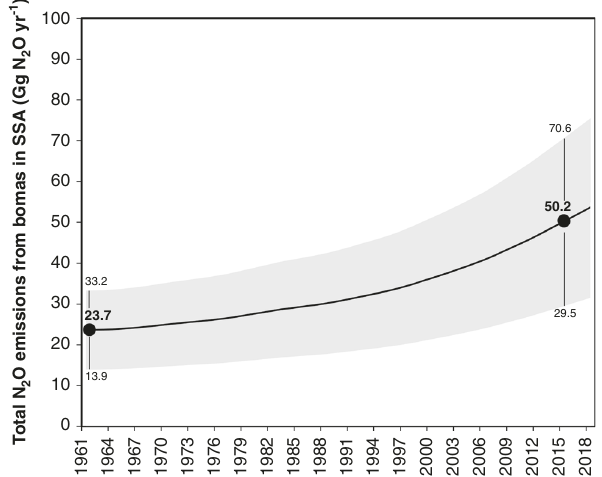
19611964196719701973197619791982198519881991199419972000200320062009201220152018 Fig. 3 Change in the source strength of abandoned bomas from 1961 to 2018. The emission trend was based on changes in livestock numbers in semi-arid and arid SSA and the calculation scheme outlined in “ Methods ” . The bold line indicates the median value, while the gray shaded area represents the upper and lower